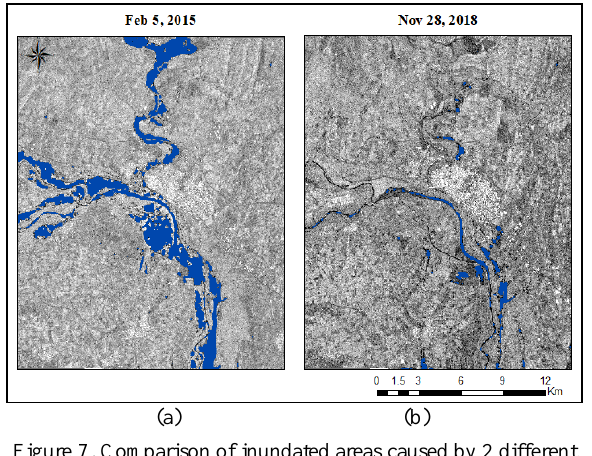
Figure 7. Comparison of inundated areas caused by 2 different floods. (a) The opening of shutters in Bulgaria dams (b) Local excessive